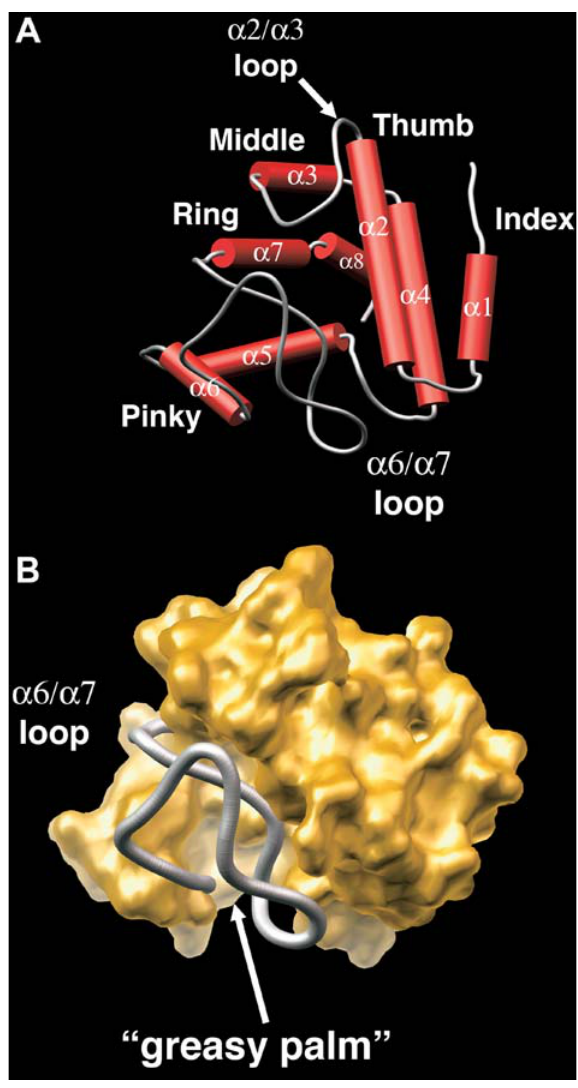
Figure 3. Close-Up View of the GUN4 Core Domain’s ‘‘ Cupped Hand ’’ Architecture (A) Rendered skeletal view of the GUN4 core domain. Helices are shown as red cylinders, and coiled regions are depicted as gray loops. The overall shape resembles that of a ‘‘ cupped hand. ’’ (B) Rendered view of the solvent-accessible surface of the GUN4 core domain, colored gold. The a 6/ a 7 loop is colored gray and is bound by the remainder of the domain. The ‘‘ cupped hand ’’ grips this loop. DOI: